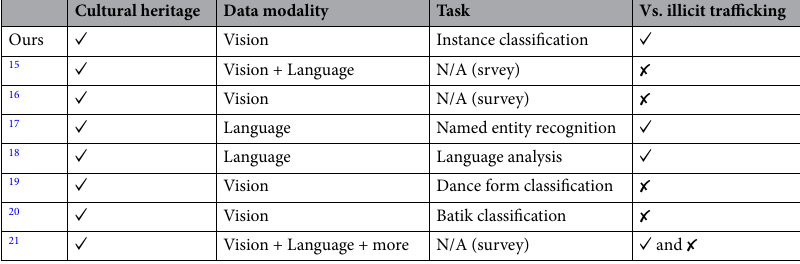
Table 1. A comparative categorical breakdown of our approach compared to similar